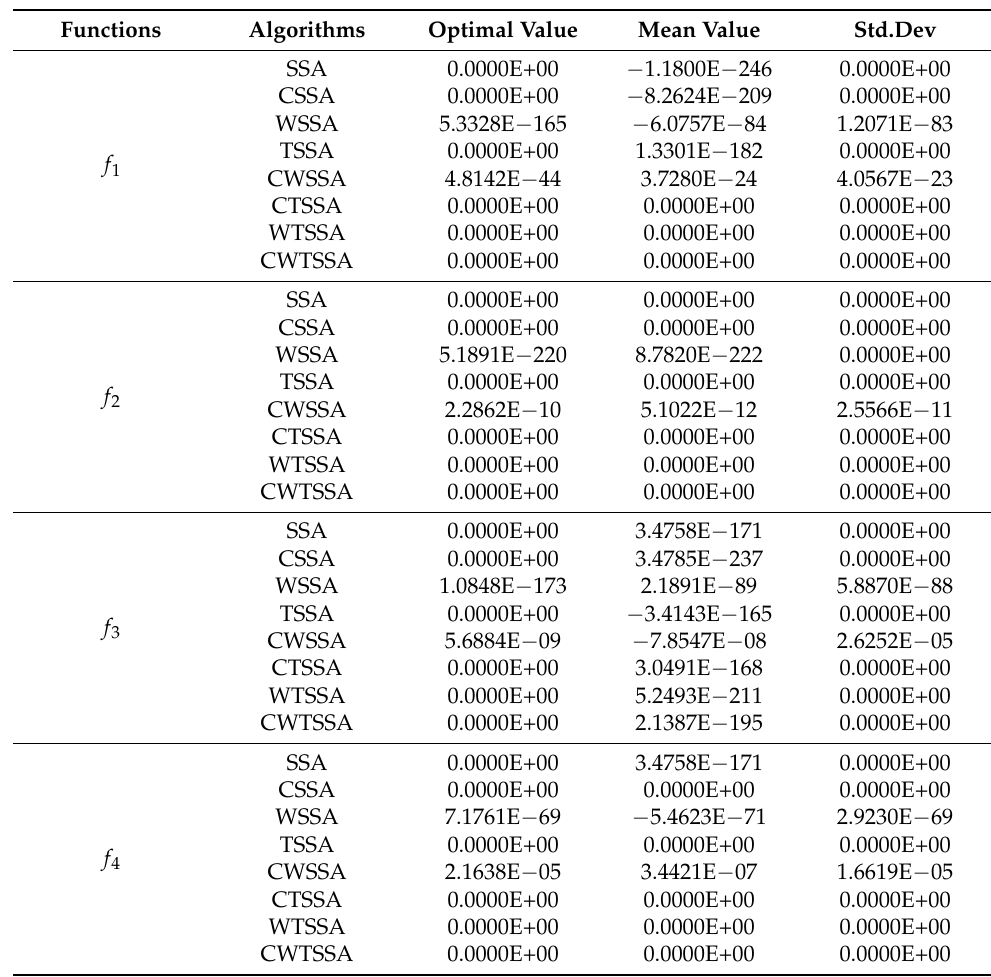
Table 3. Comparison results of the SSA with different